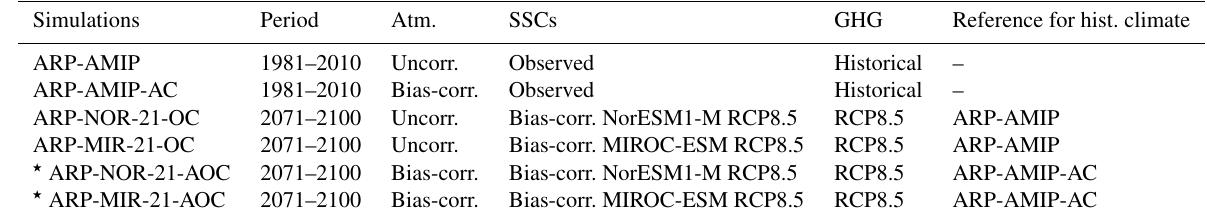
Table 1. Summary of the period, sea surface conditions, greenhouse gas concentration and reference historical simulation for each ARPEGE future projections and historical simulation presented in this study. AC, OC and AOC acronyms stand for atmospheric and/or oceanic correction. (cid:63) ARP-AMIP, ARP-MIR-21-OC and ARP-NOR-21-OC are also described in Beaumet et al.